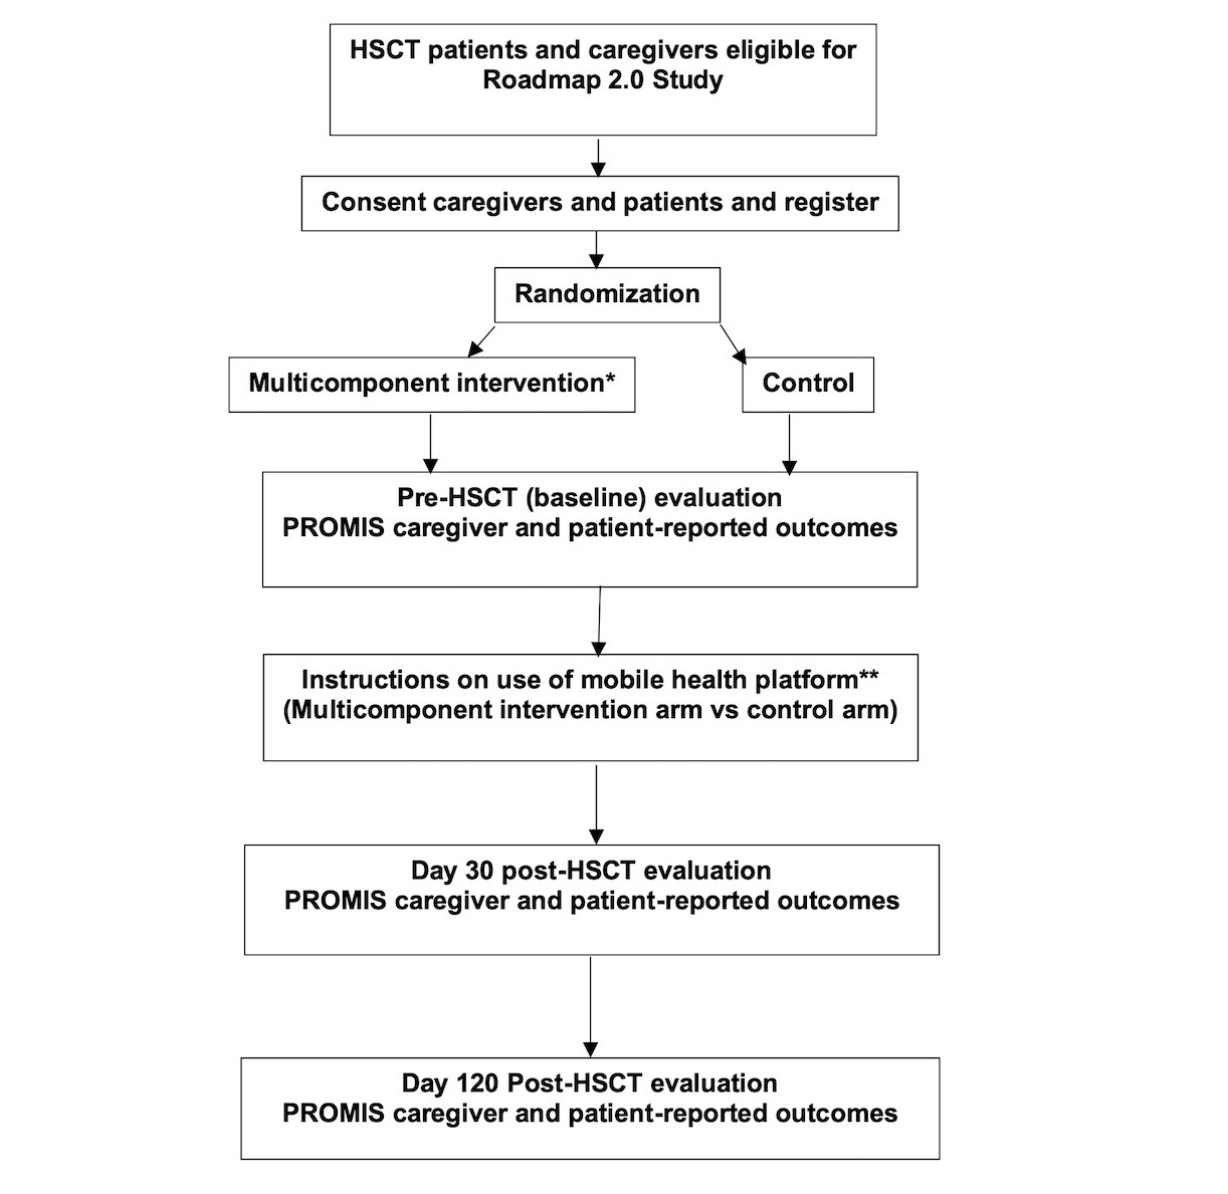
Figure 2. Study schema. HSCT: hematopoietic stem cell